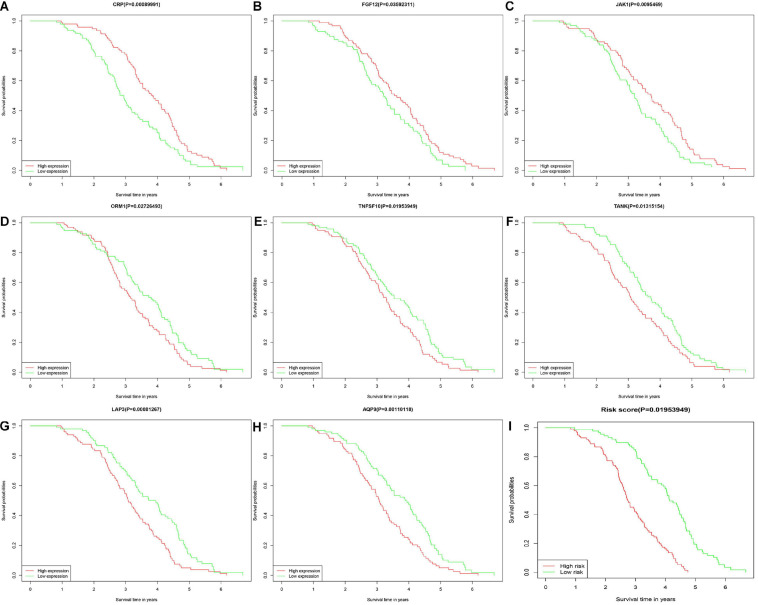
Kaplan-Meier plotters showed about overall survival of 14 IRGs in DLBCL. The horizontal axis represented the survival time by month or year. The vertical axis represented survival probability. The high-risk group marked red and low-risk group marked green. There were six IRGs with no difference in OS between high and low risk groups. (A–C) CRP, FGF12, and JAK1. (D–H) ORM1, TNFSF10, TANK, LAP3, and AQP9. (I) The low-risk group and high-risk group.